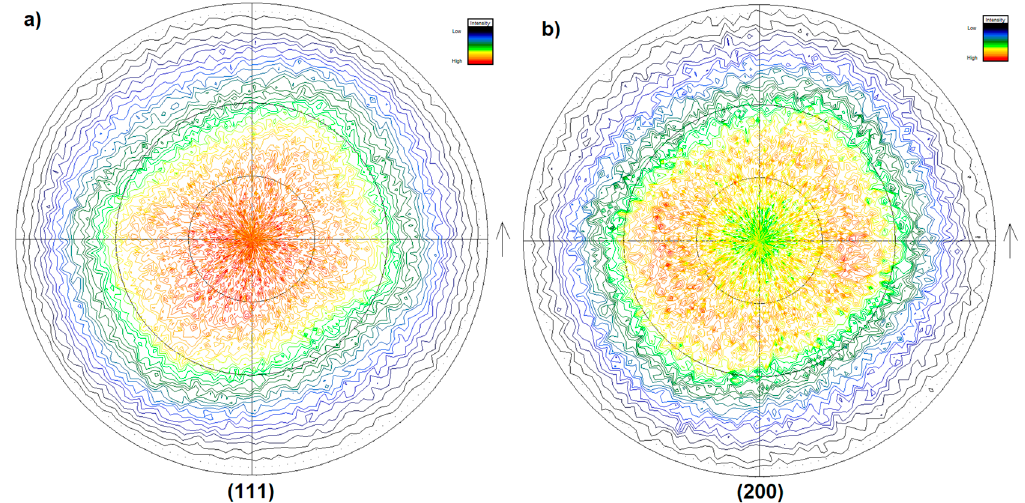
Figure 7. Pole figure of XRD texture measurement. ( a ) {111} plane and ( b ) {200} plane.